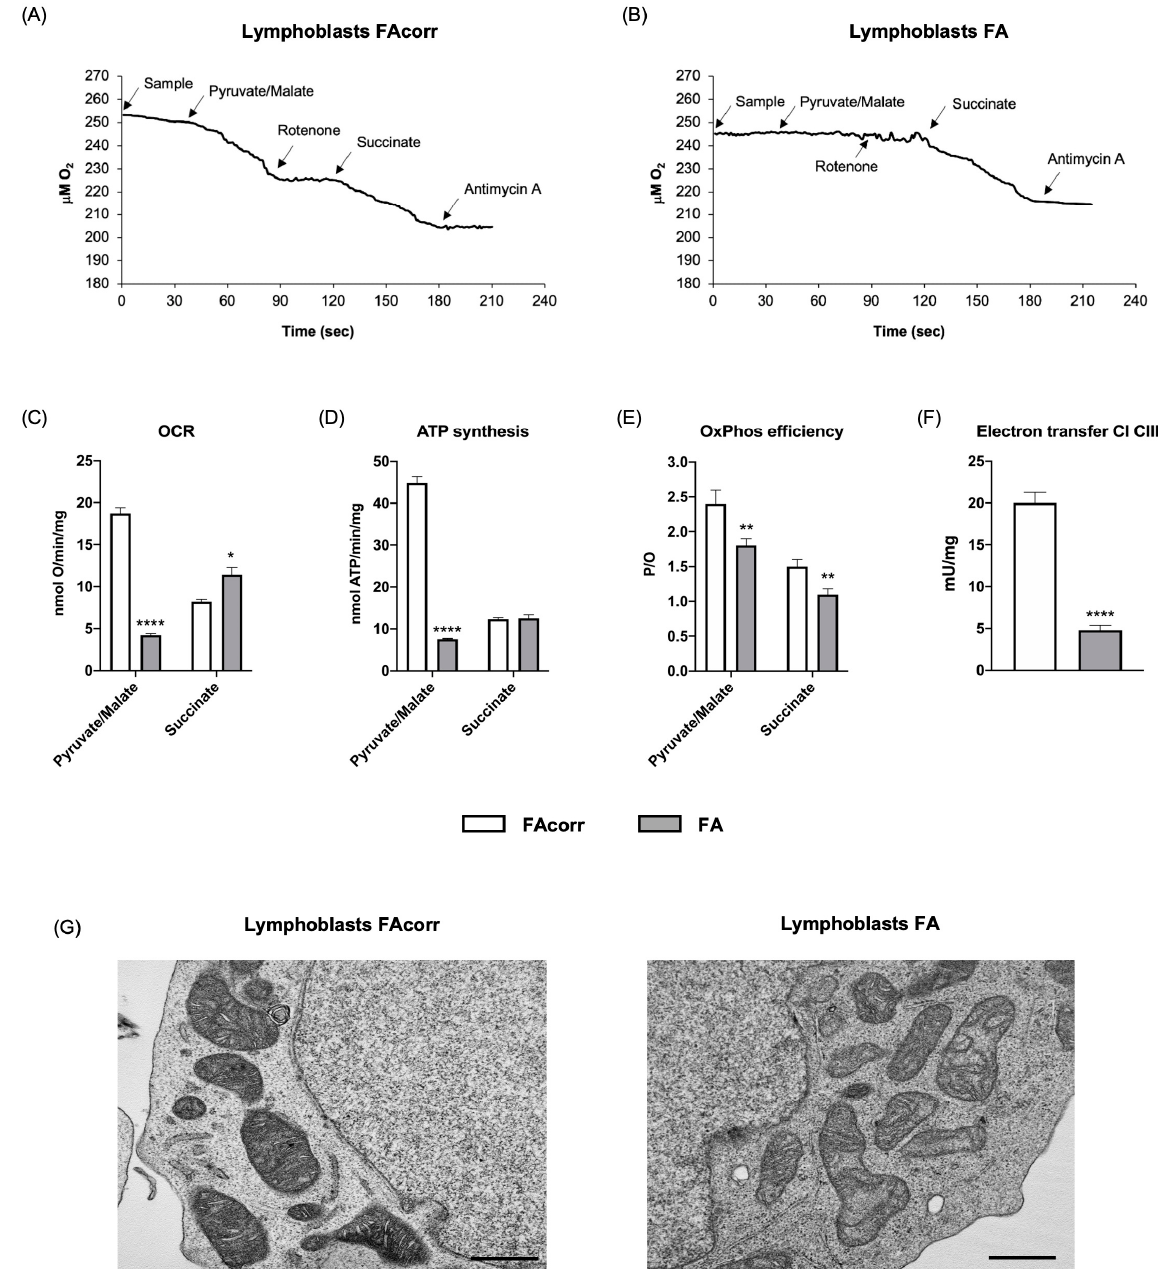
Figure 1. Aerobic metabolism and mitochondria structure in lymphoblasts mutated for the FANC-A gene. Oximetric traces of FAcorr ( A ) and FA ( B ) lymphoblasts. Arrows indicate the respiratory substrates or inhibitors’ addition. ( C ) Oxygen consumption rate (OCR). ( D ) Aerobic ATP synthesis. ( E ) P/O ratio, representing an OxPhos efficiency marker. ( F ) Electron transfer between respiratory complexes I and III. ( G ) Representative electron microscopy imaging of FAcorr and FA lymphoblasts to evaluate the mitochondrial morphology. Black scale bars correspond to 1 µ m. Data reported in Panels A–E were obtained using pyruvate/malate or succinate as respiring substrates. Data reported in Panels A–F are reported as mean ± SD, and each panel is representative of at least three independent experiments. Statistical significance was tested opportunely with an unpaired t -test or one-way ANOVA; *, **, and **** represent a significant difference for p < 0.05, 0.01, or 0.0001, respectively, between FA and FAcorr cells.